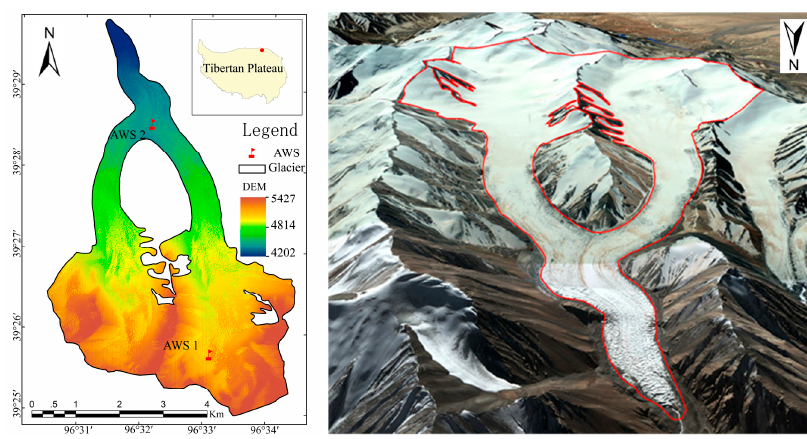
Figure 1. Location and terrain of Laohugou Glacier No. 12.